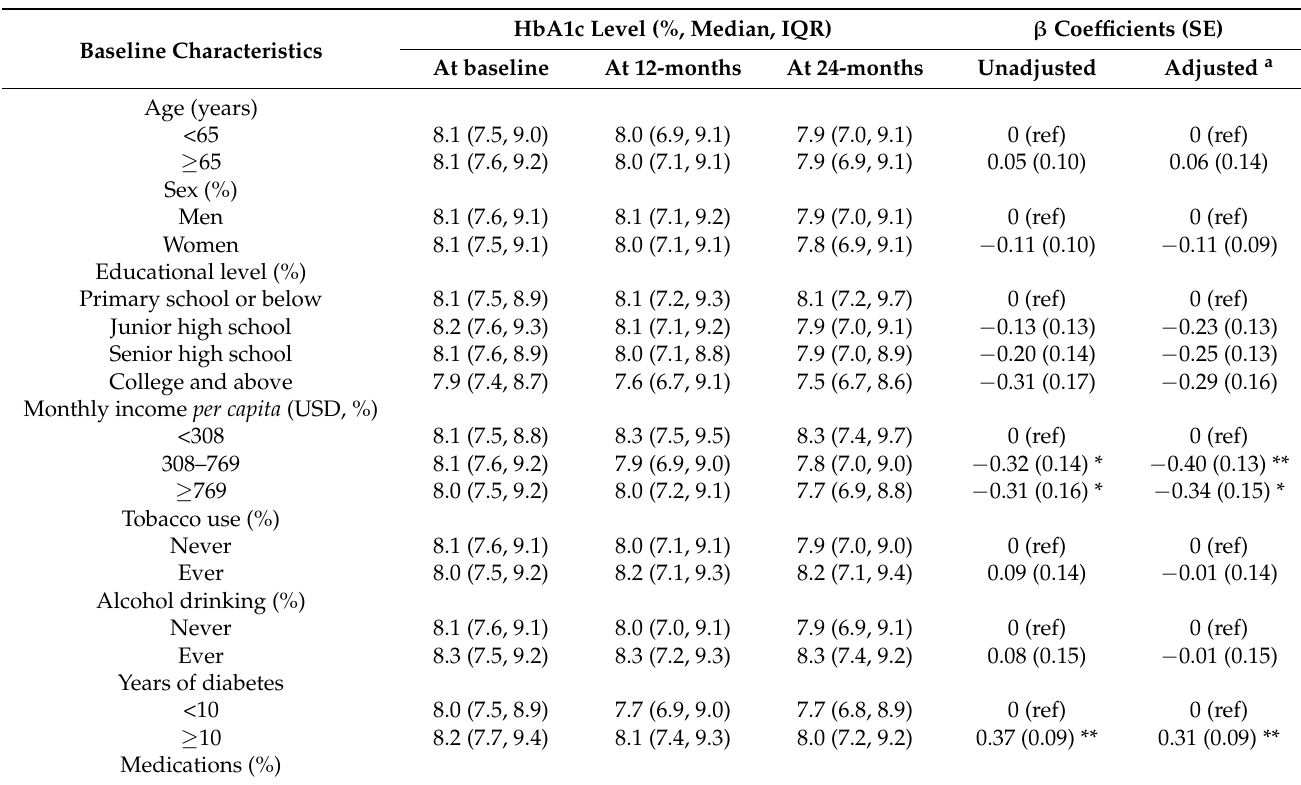
Table 2. β and 95%CI of hemoglobin A1c (HbA1c) during the following-up with baseline characteristics of the study